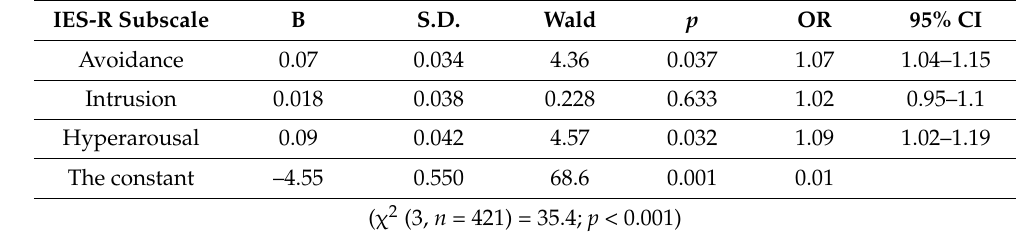
Table 3. The influence of IES-R subscales on suicidal ideation before the surgery ( n =